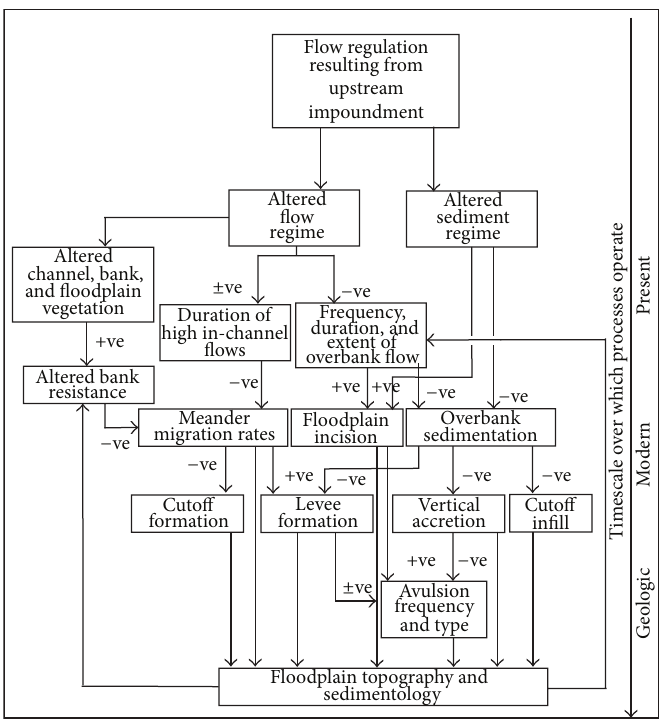
Figure 5: Conceptual model of the effects of dams on floodplain geomorphology. Timescales over which processes operate are arranged vertically through the model. +ve and –ve symbols indicate whether the changes induced by damming typically result in an increase or decrease in the rates of a particular process. Diagram is from Grove et al.